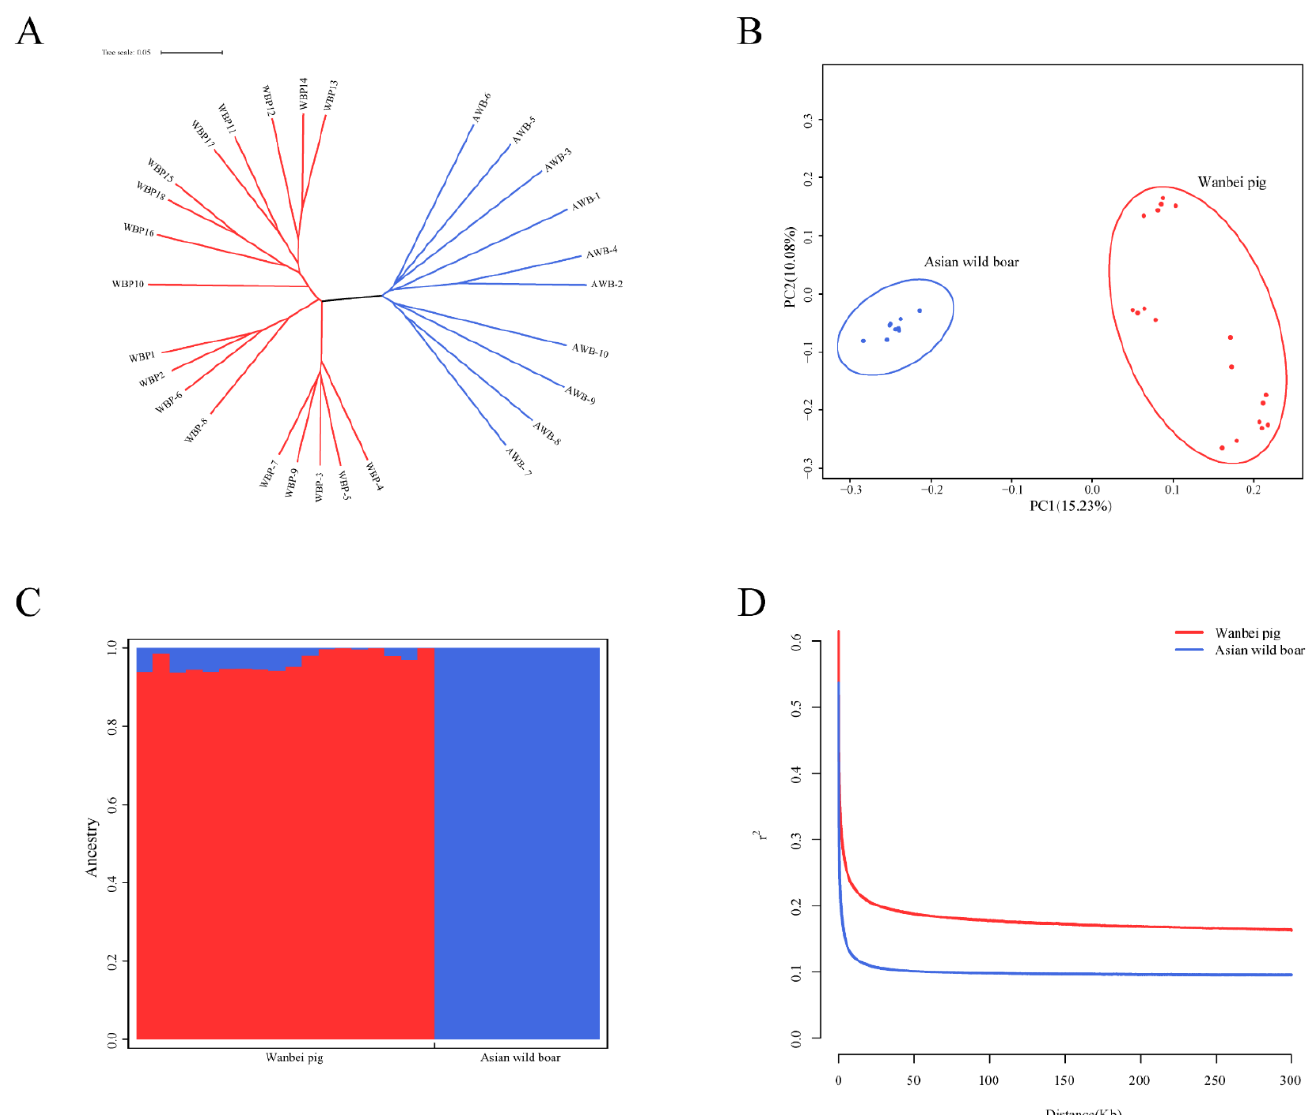
Figure 1. Population structure and LD analysis. ( A ) Neighbor-joining tree constructed from SNP data among study population. ( B ) Principal component plots for the first two PCs for all 28 individuals. ( C ) Structure analysis on all the AWB and WBP with K = 2. ( D ) Correlation coefficients (r 2 ) were calculated for the AWB and WBP over 50-kb windows.